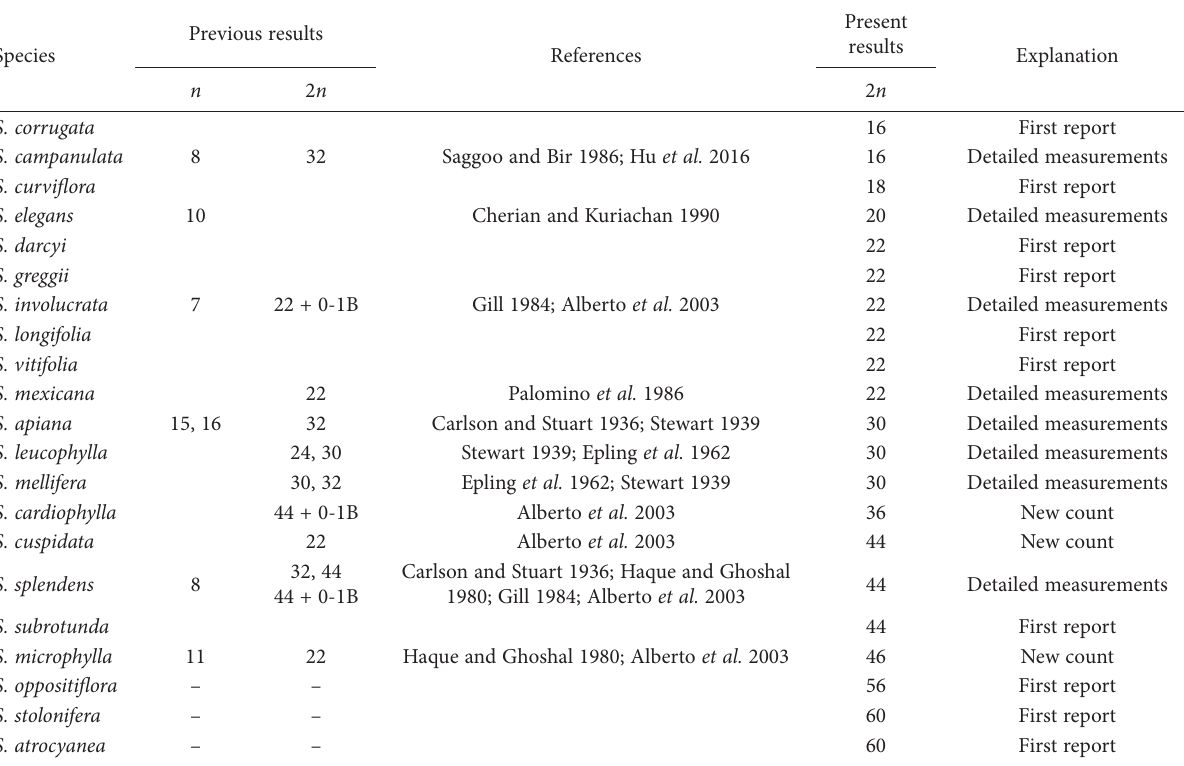
Table 1. The chromosome counts of the investigated species in present and previous studies.